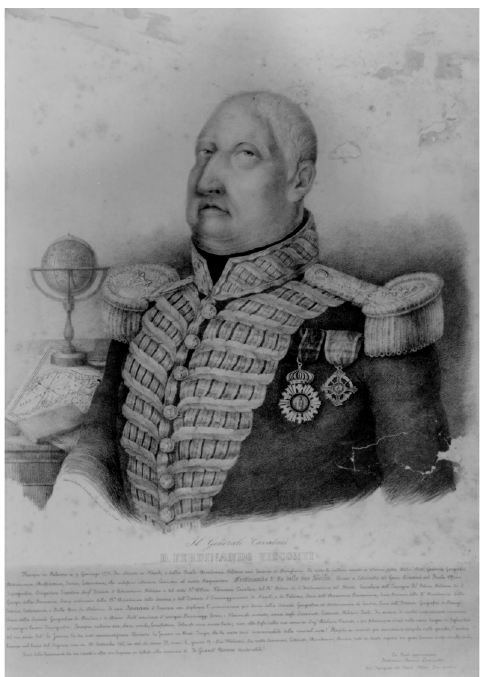
Fig. 1. Portrait of Ferdinando Visconti made in li- thography by Settimio Severo Lopresti in 1847 (Pri- vate